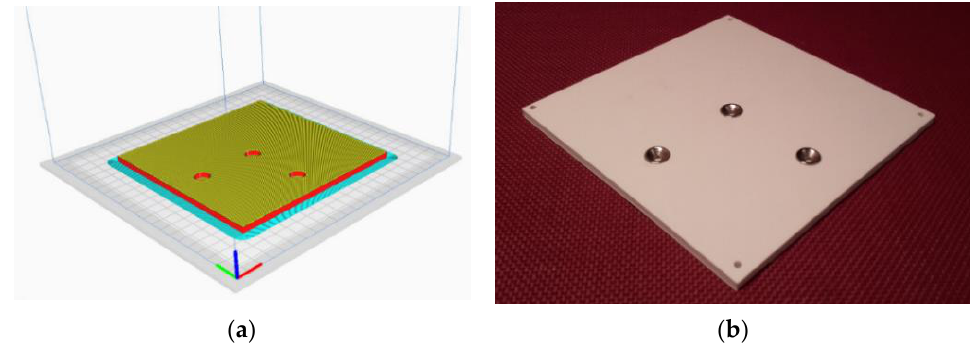
Figure 8. BPS plate bottom view: ( a ) Visualization in SolidWorks; ( b ) SolidWorks mesh model. The bottom BPS plate “slice phase” and the finished part with installed magne tic